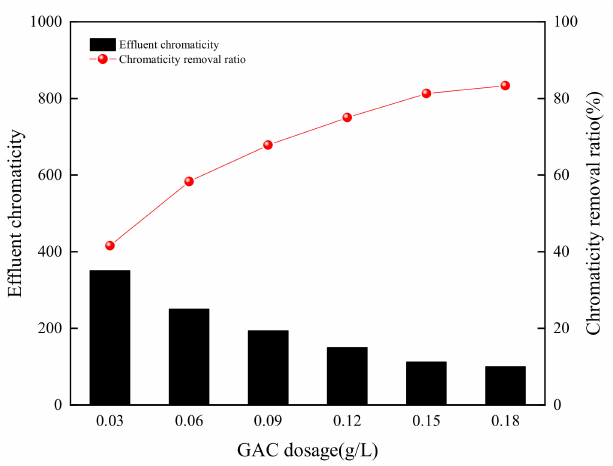
Figure 3. Granular activated carbon (GAC) dosage effect on chromaticity removal from simulated